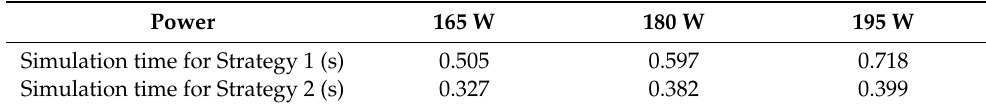
Figure 16. 195 W constant-power condition. ( a ) Temperature contrast. ( b ) Power comparison. Table 9. Simulation time per cycle for two strategies. Table 9. Simulation time per cycle for two strategies.